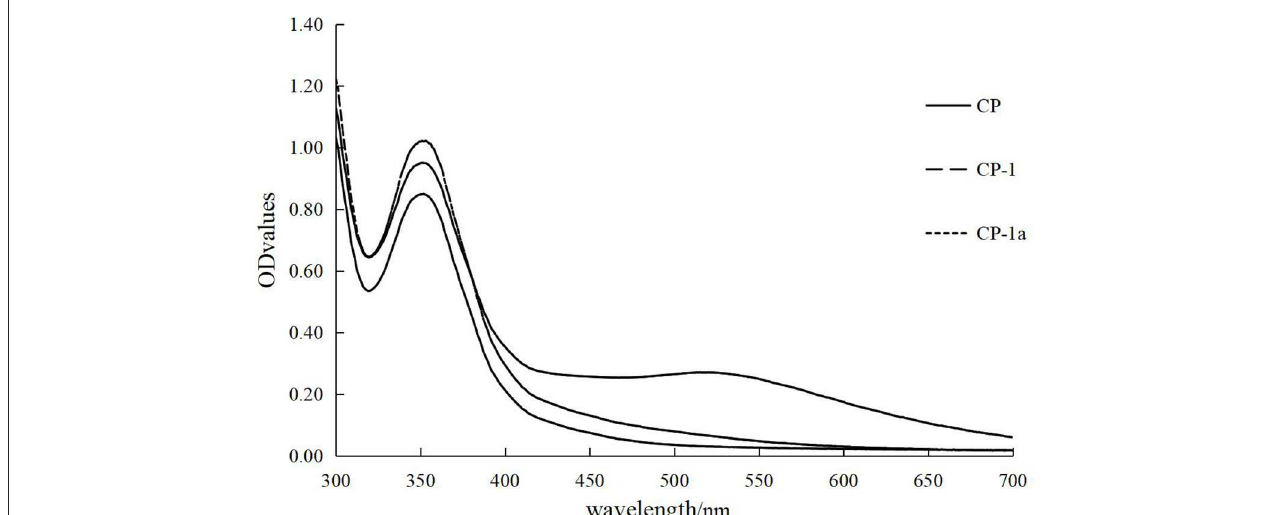
FIGURE6 I 2 -KI reaction of CP, CP-1, and CP-1a.